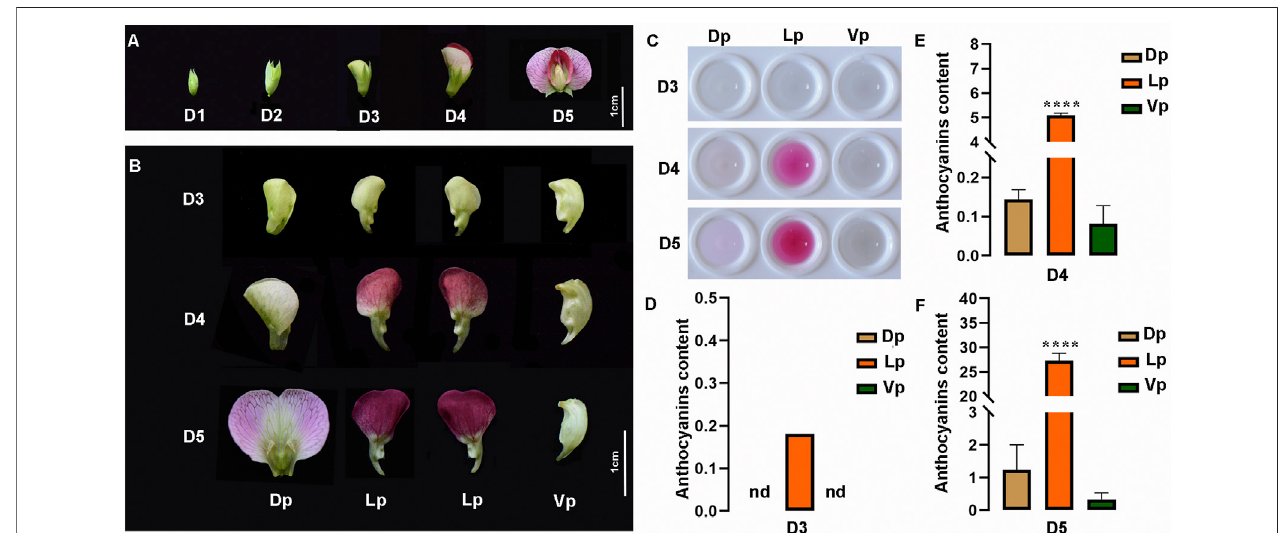
FIGURE 5 | Characteristics of pea fl owers during different developmental stages. (A) Morphological analysis of pea fl owers. Bub length < 0.6 cm, 0.6 – 0.7 cm, 0.9 – 1 cm,1.3 – 1.9 cm, > 2 cmarede fi nedasdevelopmentalstageD1toD5,respectively. (B) Morphologicalanatomyofpea fl owersduringD3toD5.Dp,Dorsalpetals; Lp,Lateralpetals;Vp,Ventralpetals.nd,notdetected. (C) ThecrudepigmentextractionfromDp,Lp,andVpatD3toD5. (D – F) ThetotalanthocyanincontentsintheDp, Lp, and Vp of D3 (D) , D4 (E) , D5 (F) were detected by ultraviolet spectrophotometer, computed as (A 530 -0.25 × A 657 )/FW (g − 1 FW). The data are the mean ± SD from three biological replicates. ** p < 0.05. **** p < 0.0001, Ordinary one-way ANOVA; nd, not detected; Bar = 1